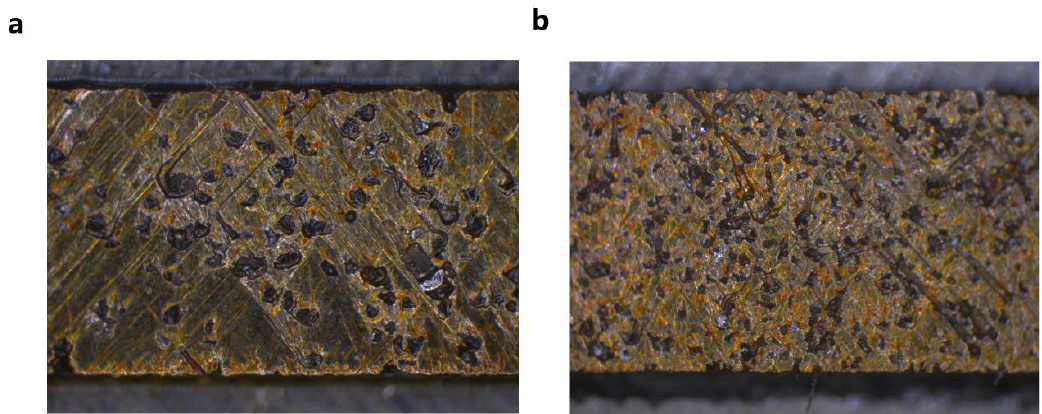
Figure 3. Magnified image of the abrasives’ surfaces of: ( a ) Experiment 2 and ( b ) Experiment 7.